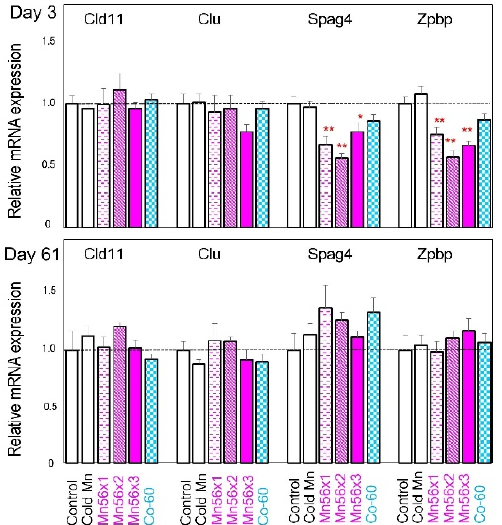
Figure 3. Relative mRNA expression levels of Cld11, Clu, Spag4, and Zpbp genes in the testes of the rats on Day 3 ( top ) and Day 61 ( bottom ) following exposure to 56 MnO 2 powder (Mn56 × 1, Mn56 × 2, and Mn56 × 3), Cold MnO 2 powder (Cold Mn), or 60 Co- γ exposure (Co-60). * p < 0.05 and ** p < 0.01 vs. control.